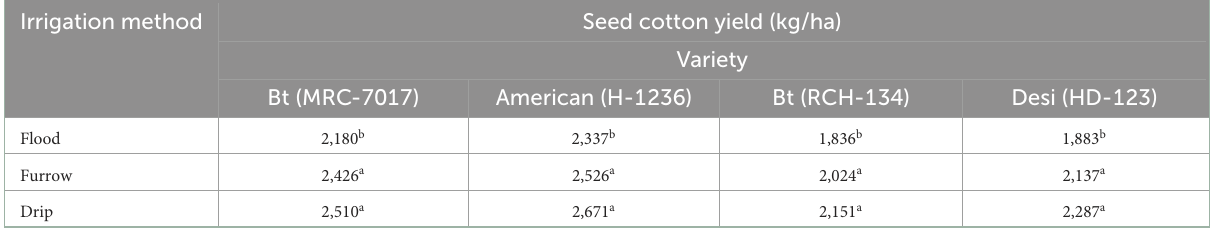
TABLE 3 Effect of different irrigation methods on seed cotton yield (kg/ha) of different cultivars at 5% probability. Irrigation